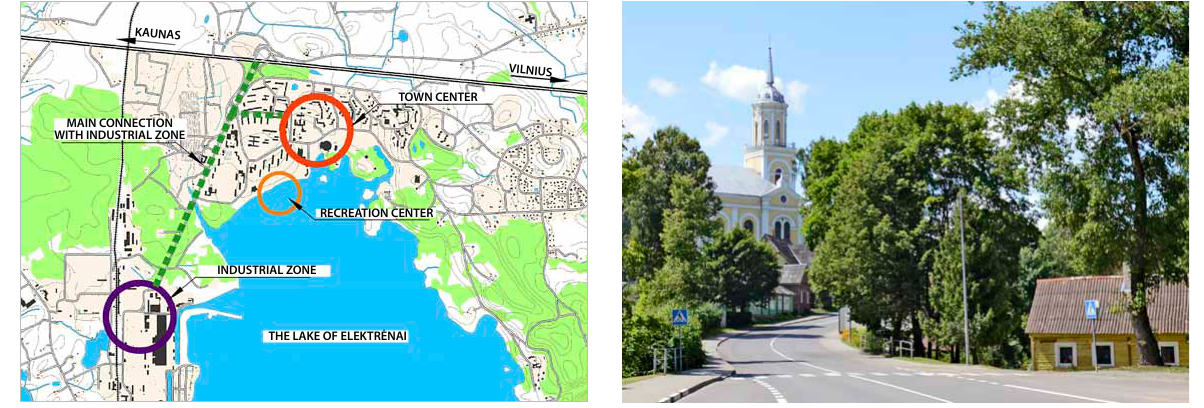
fig. 19. The plan of the town of Elektrenai fig. 21. an internal area of the small town (Kavarskas) with abundant greenery and a common 1 storey